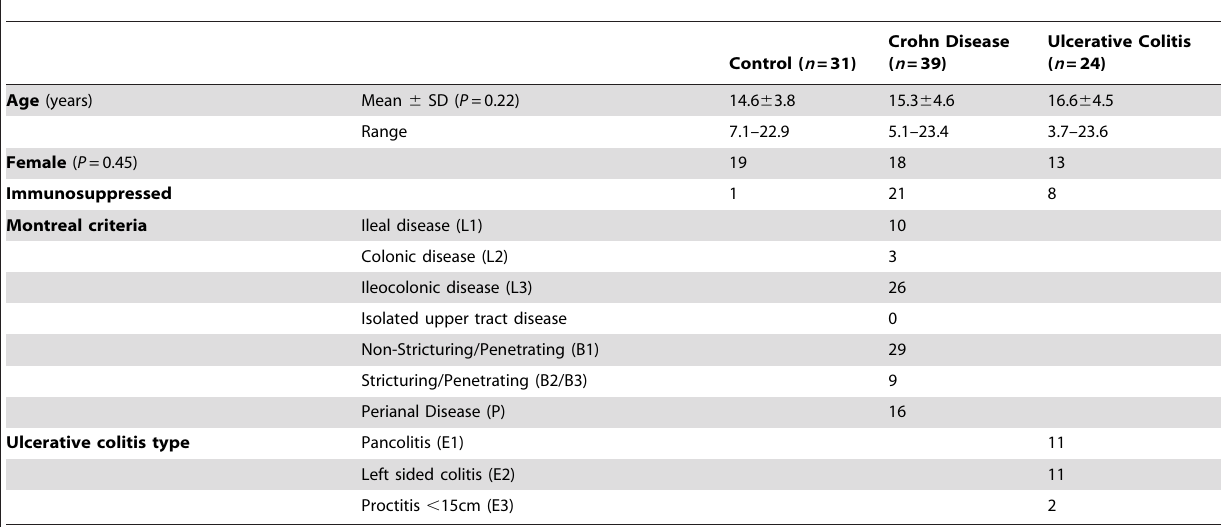
Table 1. Study population demographics and disease